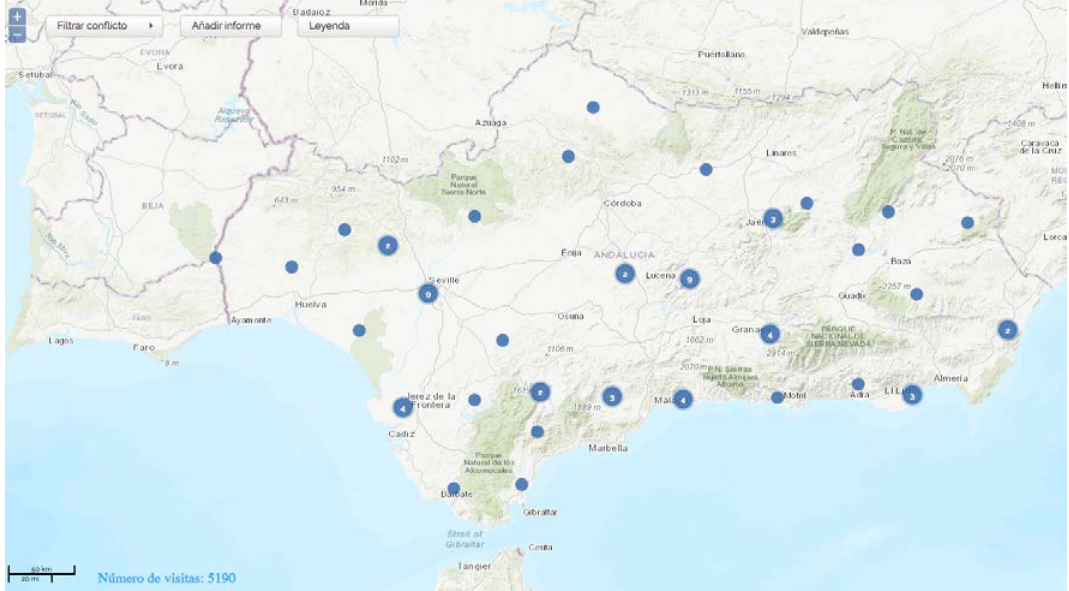
Figure 1. Interface of the participatory webmap of water conflicts in Andalusia (Spain). Note: a small dot indicates a conflict site. The larger dots identify the sites of two or more conflicts. These disaggregate when zooming in on the map and pinpoint the locations with greater precision. Source: Map-Red-Nueva Cultura del Agua (RedNCA), https://redandaluzaagua.org/mapa/ retrieved December 2019.